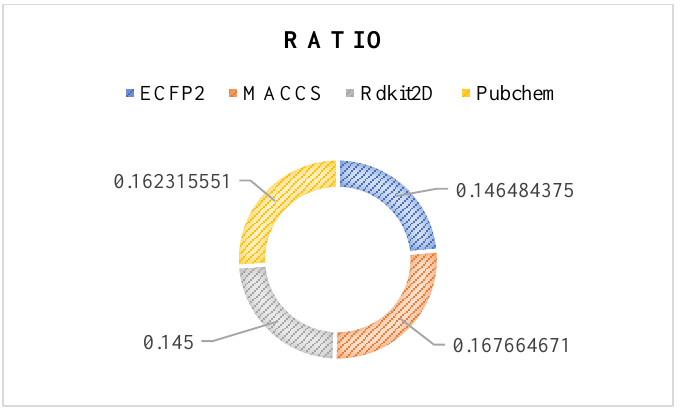
Figure 10. The ratios obtained by dividing the number of features of various fingerprints in the top 500 by the number of their original inputs are compared.